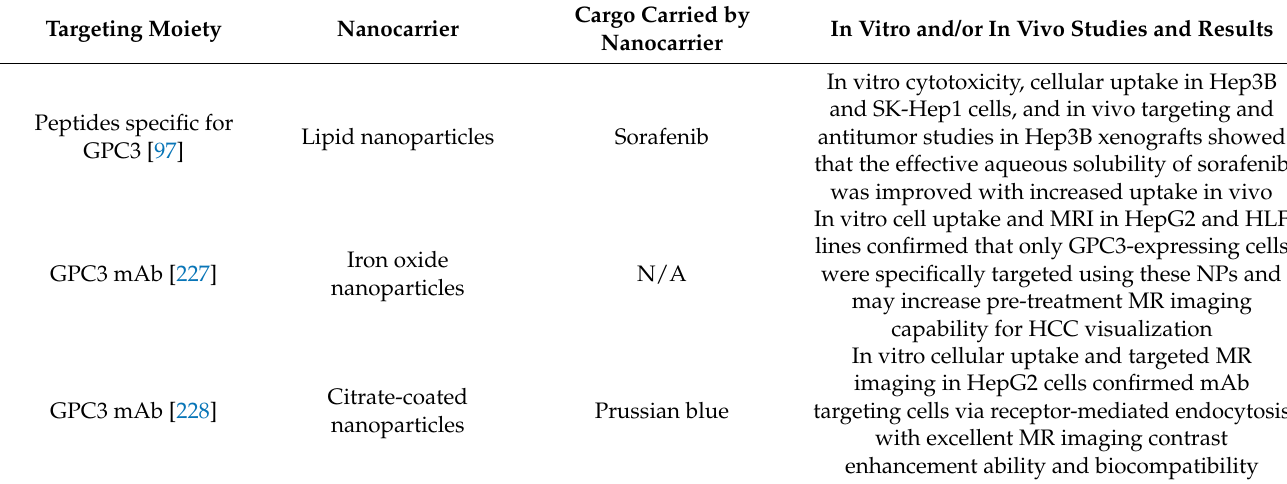
Table 3. Summary of different nanoformulations designed using GPC3 as a targeting